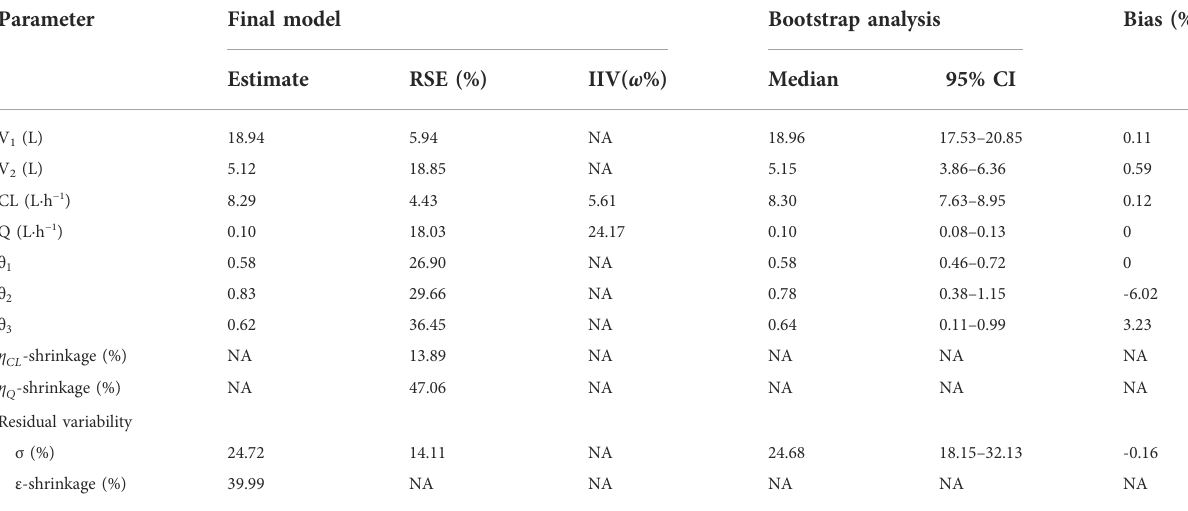
TABLE 2 Population pharmacokinetic parameters of PEM and bootstrap results (n = 1,000). Parameter